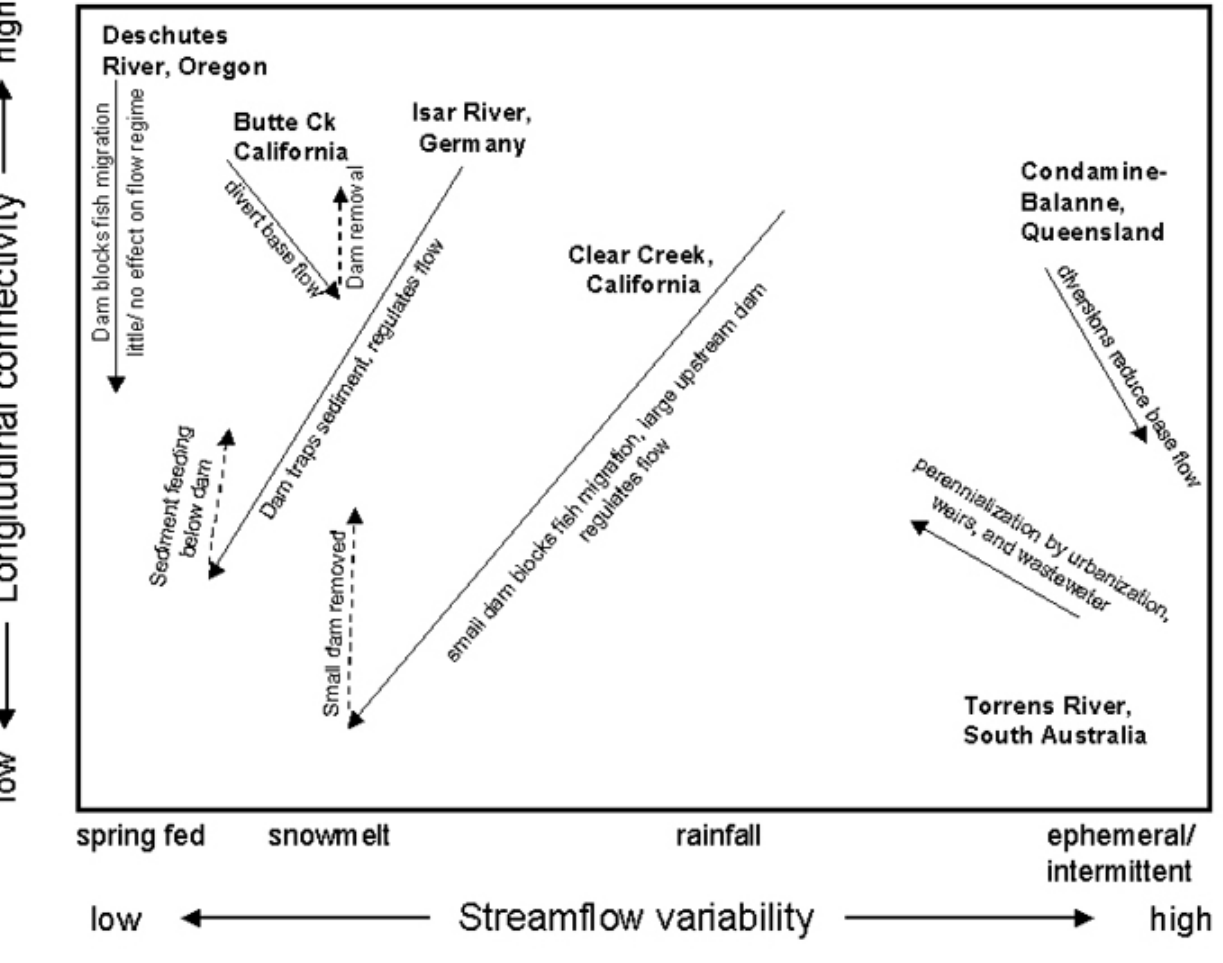
Fig. 1. Solid arrows represent ecological degradation and dashed arrows represent restoration trajectories plotted on axes of longitudinal connectivity and flow dynamics. See Appendix 1 for a discussion of